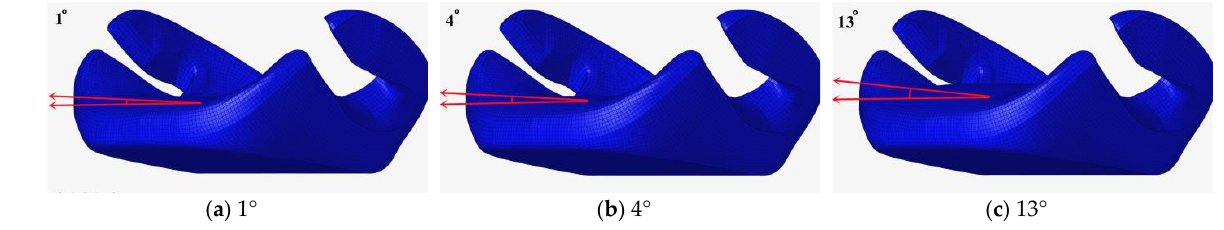
Figure 14. Seat cushion angles: 1° ( a ); 4° (reference model) ( b ); 13° ( c ).